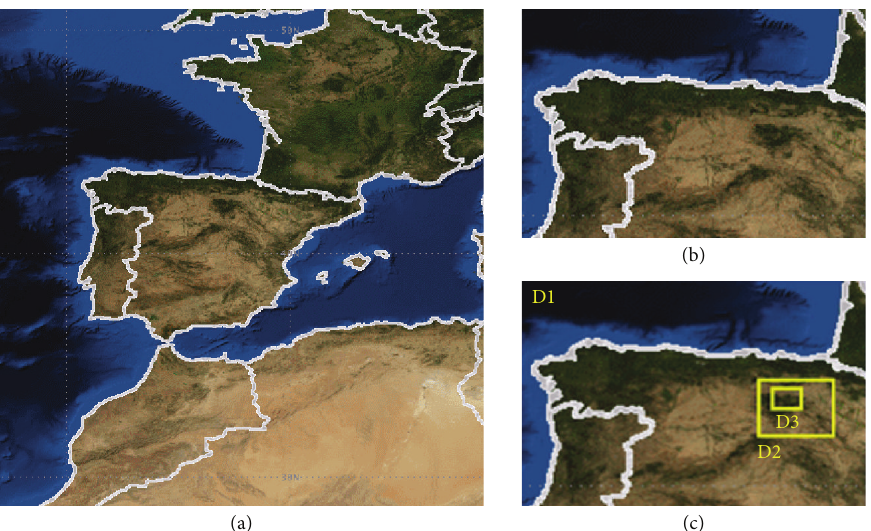
Figure 4: (a) Mother domain 1. (b) Mother domain 2. (c) Domains for Logro˜no with the mother domain